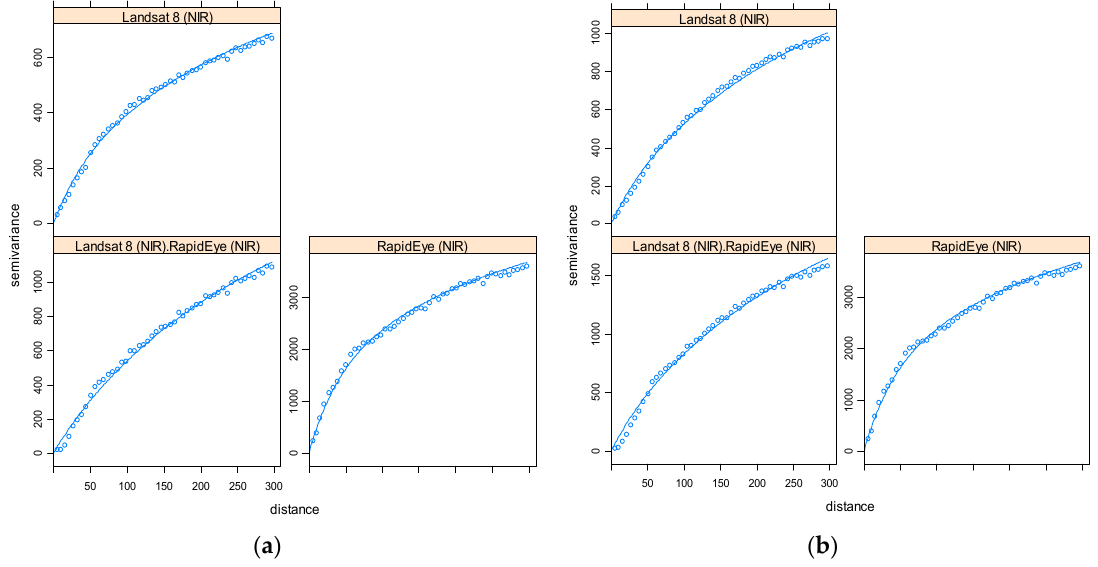
Figure 6. The variogram and cross-variogram between the Landsat 8 NIR band and RapidEye NIR band (image value = Reflectance × 1000). ( a ) Landsat (1 July); ( b ) Landsat (5 October). Table 3. Variogram models used in downscaling cokriging.